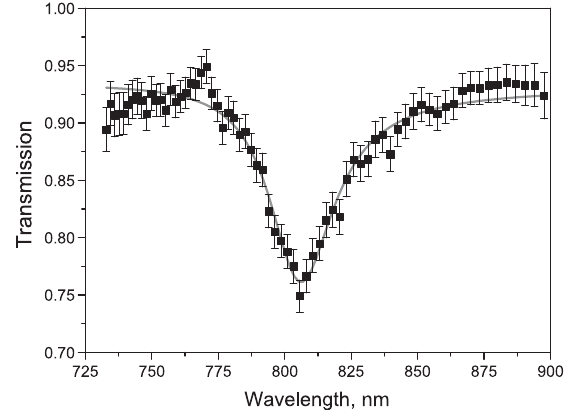
FIG. 4. Transmission spectrum of the nanoparticle array in homogeneous PDMS surroundings measured via quantum spec- troscopy. The gray solid line is a fit with the Fano formula (R 2 ¼ 0 . 94 ). The error bars are the standard